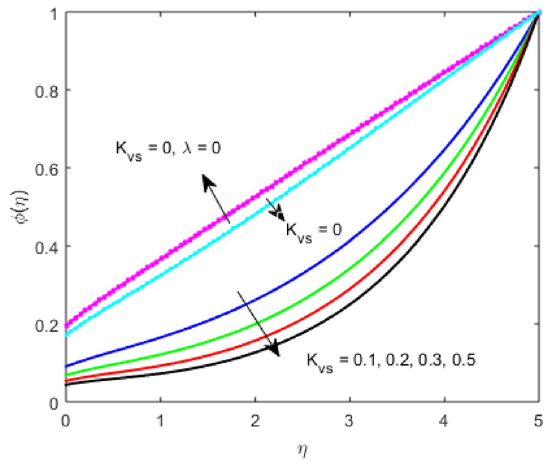
Figure 3. Concentration distribution for varying K vs .